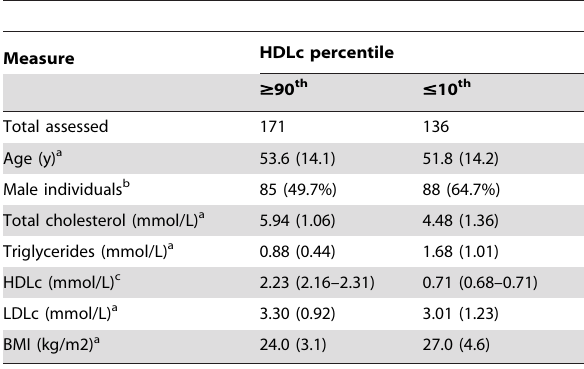
Table 1. Demographics of unrelated probands with extreme HDLc.